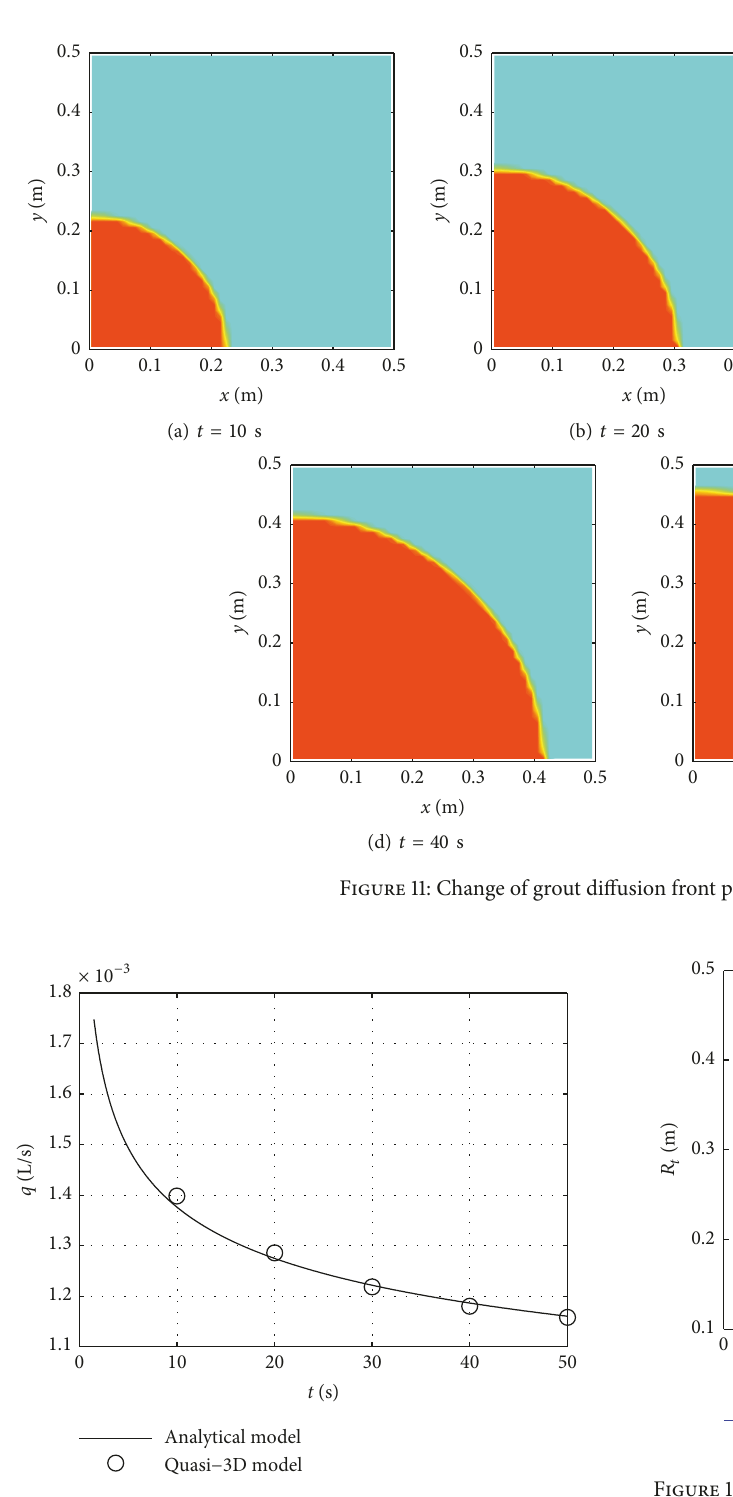
Tables 8 and 9 show the contrast of the radial pressure and average velocity calculated by the quasi-3D model and the analytical model at t = 20 s and t = 50 s, respectively. The distributions of the pressure and average velocity at different moments are plotted in Figures 14 and 15, respectively.